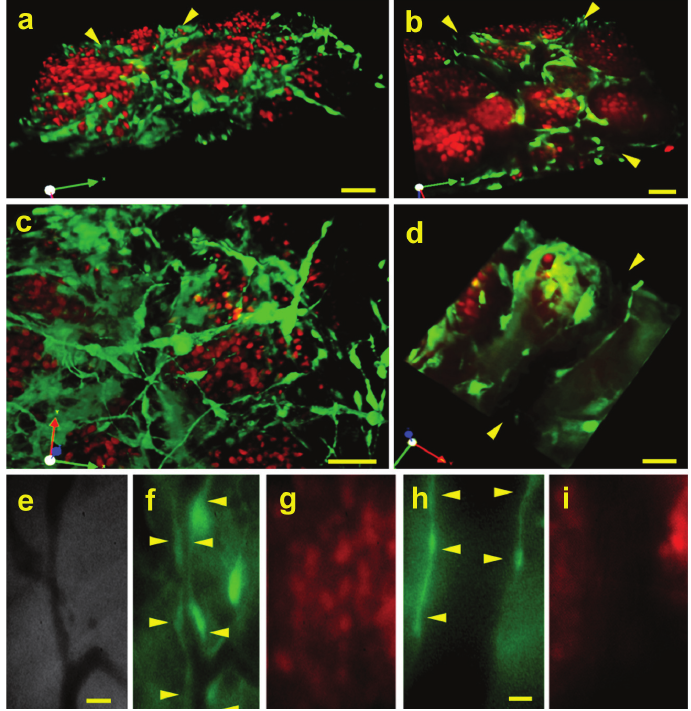
Figure 2. Distinct fluorescence imaging of tumor cells, tissue stroma and vasculature. N202 H2B-mCherry mammary tumor spheroids (red) were implanted with mammary tissue excised from a lactating GFP mouse (green) or from a mouse expressing GFP under the EC- specific TEK promoter (TEK-GFP). 20 days post-implantation, 3D confocal fluorescent microscopic images were constructed ( a – d : GFP, h and i : TEK-GFP) as well as direct IVM fluorescent microscopic images ( e – g : GFP) of the tumor and tissue stroma. Blood vessels are indicated by arrowheads. Scale bars = 10 μm ( a – d ), 20 μm ( e – g ), 5 μm ( h and i